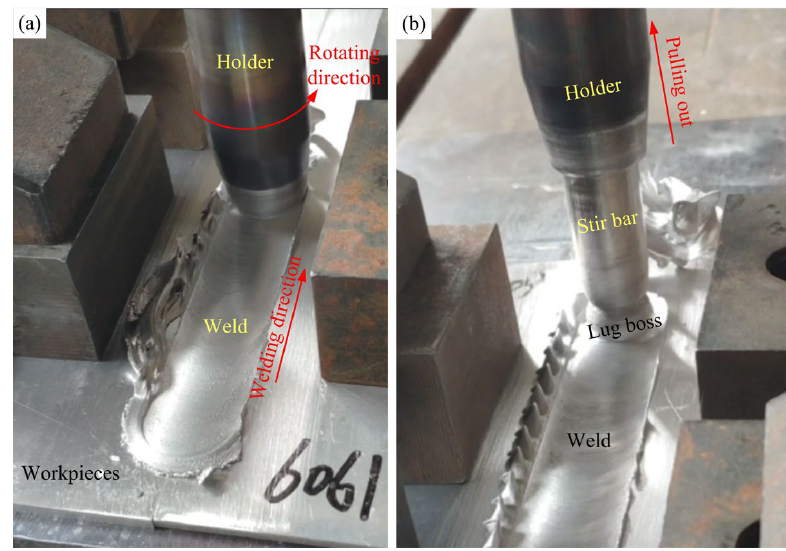
Figure 3. The VFSW process: ( a ) tool traversing stage; ( b ) tool pulling-out stage.